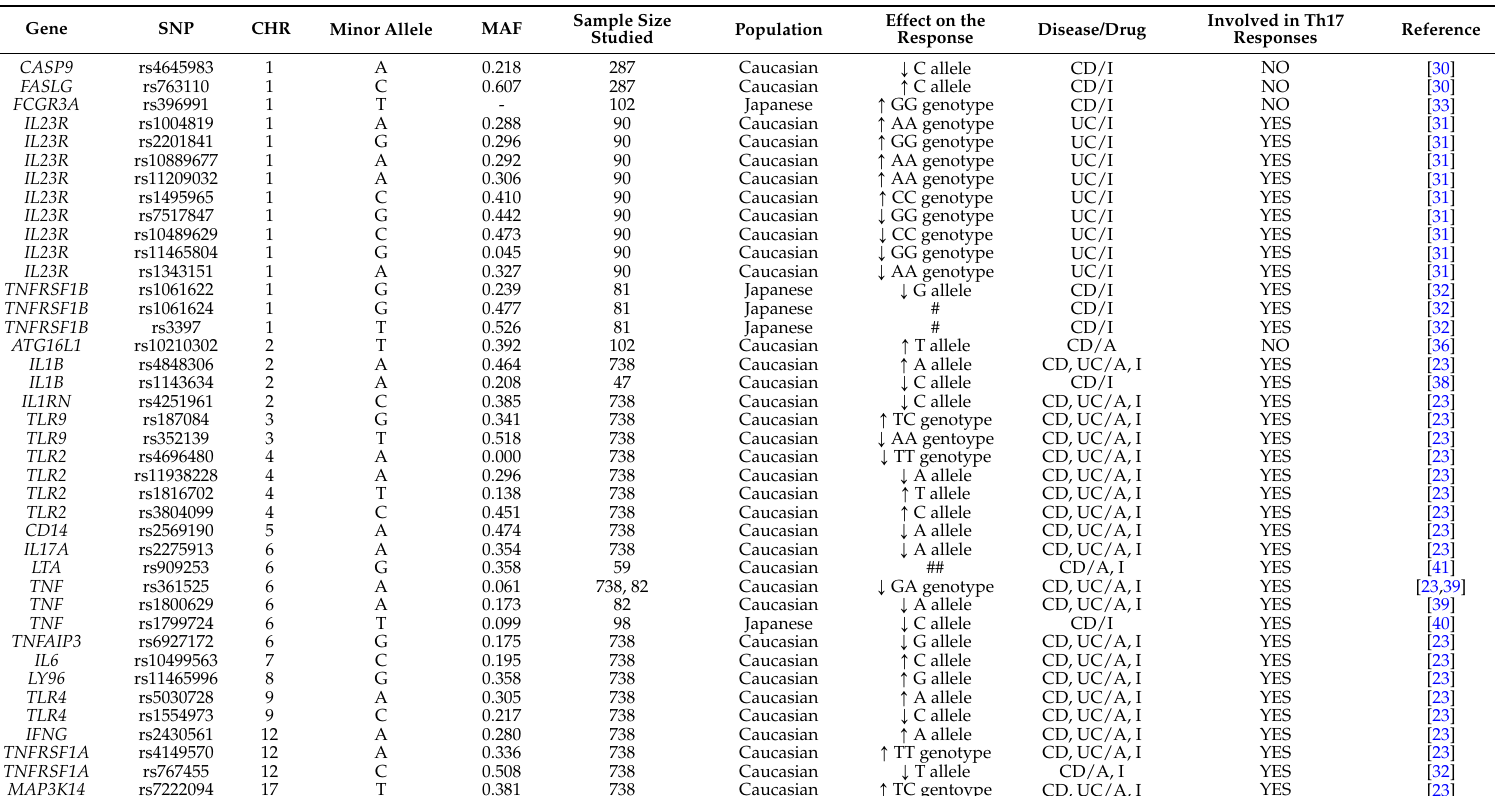
Table 1. Association between single-nucleotide polymorphisms SNPs and response to anti-tumor necrosis factor (TNF) drugs (infliximab and/or adalimumab) in patients with inflammatory bowel